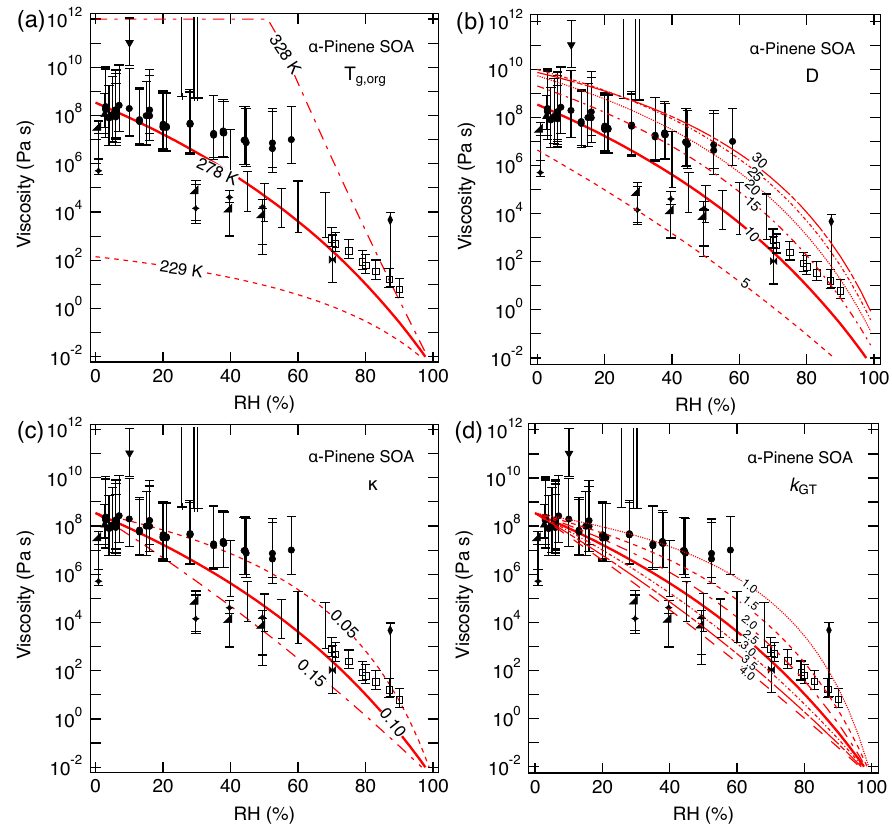
Figure 5. Sensitivity calculations for the viscosity of α -pinene SOA at 295K as a function of RH by varying (a) the glass transition temper- ature of dry SOA ( T g , org ) , (b) fragility ( D) , (c) hygroscopicity ( κ) , and (d) the Gordon–Taylor constant ( k GT ) .